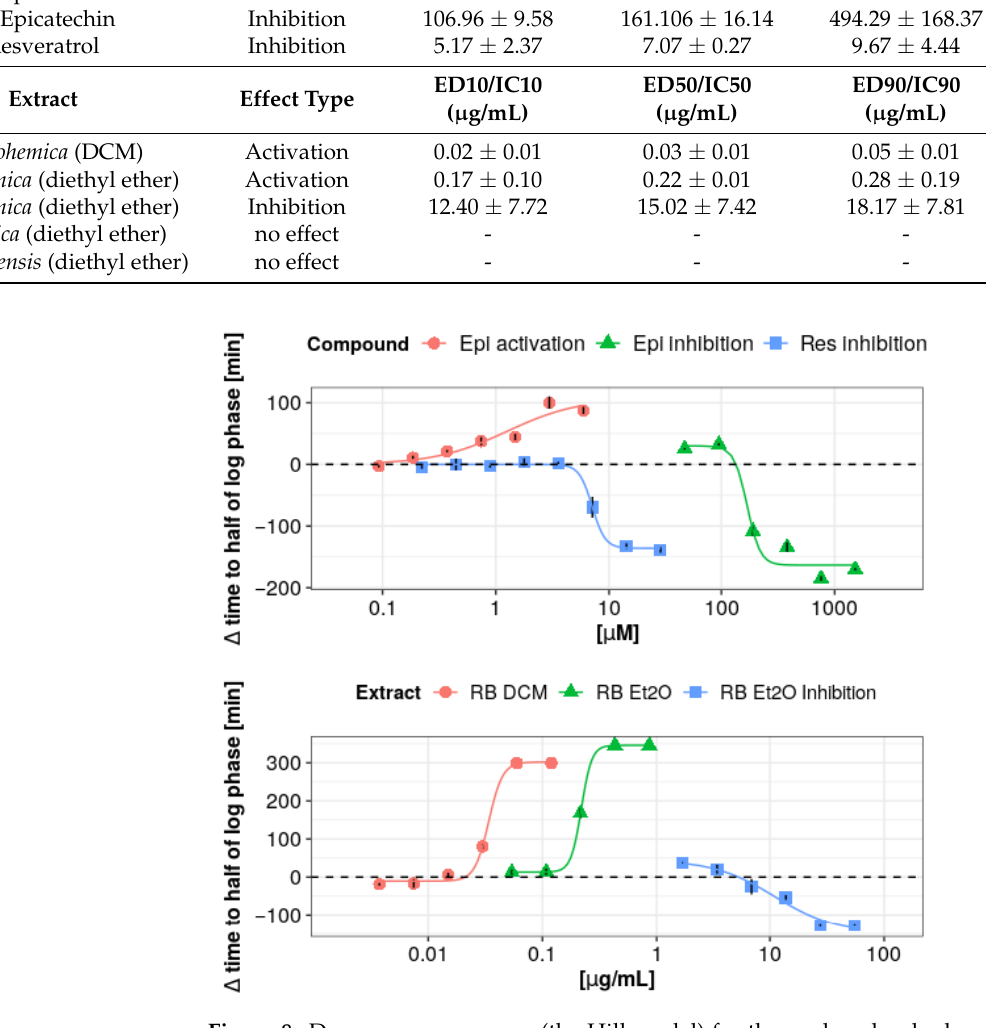
Figure 8. Dose–response curves (the Hill model) for the analyzed polyphenols and extracts that showed activating or inhibiting antimicrobial effect on the LPO system. Abbreviations: Epi, (-)-epicatechin; Res, resveratrol; RB, R. x bohemica ; DCM, dichloromethane; Et2O, diethyl ether.